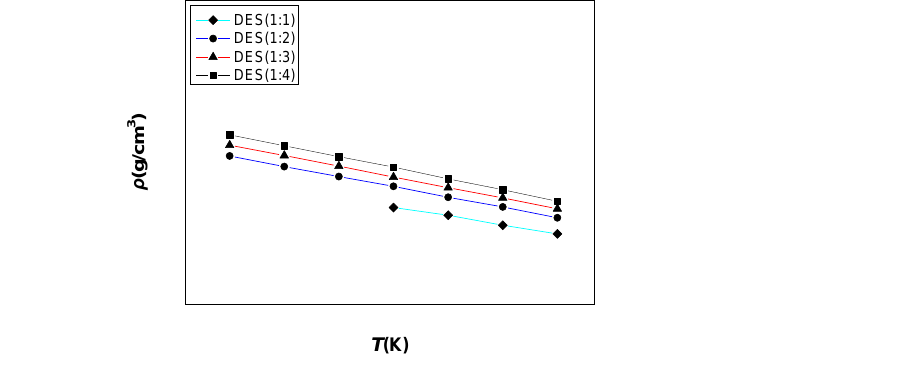
The viscosity of DES(1:1–1:4) was measured under different temperatures between 293.15 and 353.15 K at atmospheric pressure. Since DES(1:1) is not in the liquid state at room temperature, its viscosity is measured from 323.15 K (Figure 3). From Figure 3, it is inferred that between 293.15 and 353.15 K, the viscosity values of DES are found in the range from 1000 to 10 mPa·s, which follows the same trend as observed in the ionic liquid. Till the temperature is 333.15 K, the viscosity decreases enormously with each step increase in temperature rise. After reaching 333.15 K, the change in viscosity is slow, showing a gradual decrease. Furthermore, it is to be noted that with the increase in HBD content, the density decreases.